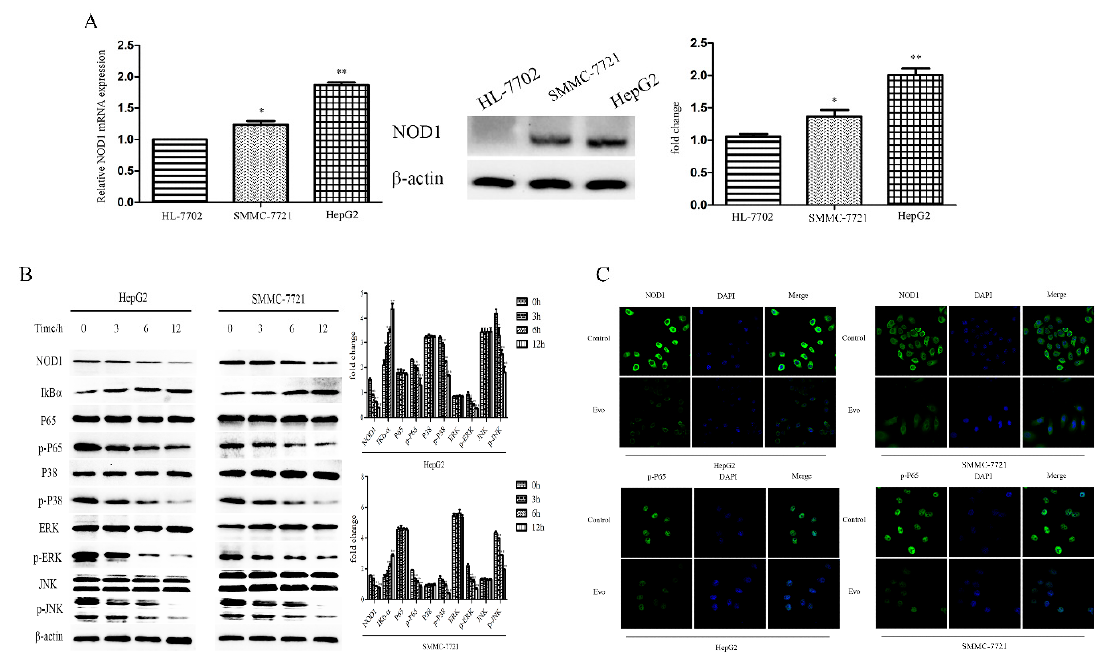
Figure 2. Evo decreases expression of NOD1 resulting in suppression of nuclear factor- κ B (NF- κ B) and mitogen-activated protein kinase (MAPK) activation in vitro. ( A ) Expression of NOD1 in normal hepatocyte HL-7702, HepG2, and SMMC-7721 cells were detected by qRT-PCR and Western blot assays. ( B ) HepG2 and SMMC-7721 cells were incubated with 1 µ M Evo for 0, 3, 6, and 12 h. The Western blot assay was performed to detect levels of proteins in the NOD1 pathway. ( C ) Representative images from the immunofluorescence method ( × 400). HepG2 and SMMC-7721 cells were incubated with or without Evo (0, 0.5, and 1 µ M) for 24 h to detect levels of NOD1 and p-P65. Values are means and standard errors of three separate experiments (* p < 0.05 and ** p < 0.01 versus control).